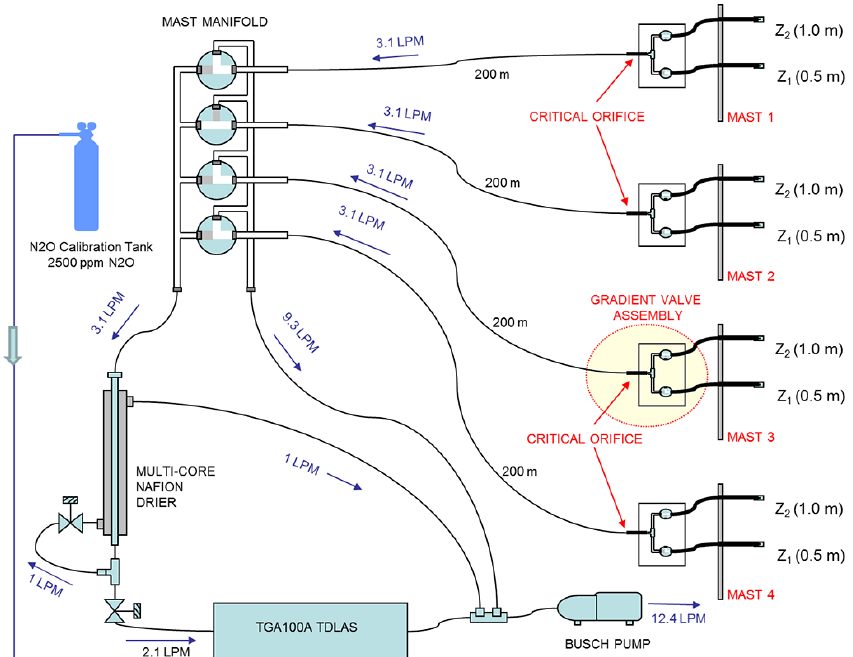
Fig. 2. Schematic diagram of FS-NOMAS plumbing. Each gradient valve assembly selects air from either inlet z 1 and z 2 every 6 or 9s. All air streams are routed towards the Busch pump. One of the four air streams is diverted through the Nafion drier and the TDLAS for N 2 O analysis. Every 20 or 30min the mast sampling manifold switches so that another air stream is analysed. The N 2 O signal in the TDLAS sample cell is continuously referenced to the signal of the reference cell that is continuously flushed with the N 2 O calibration